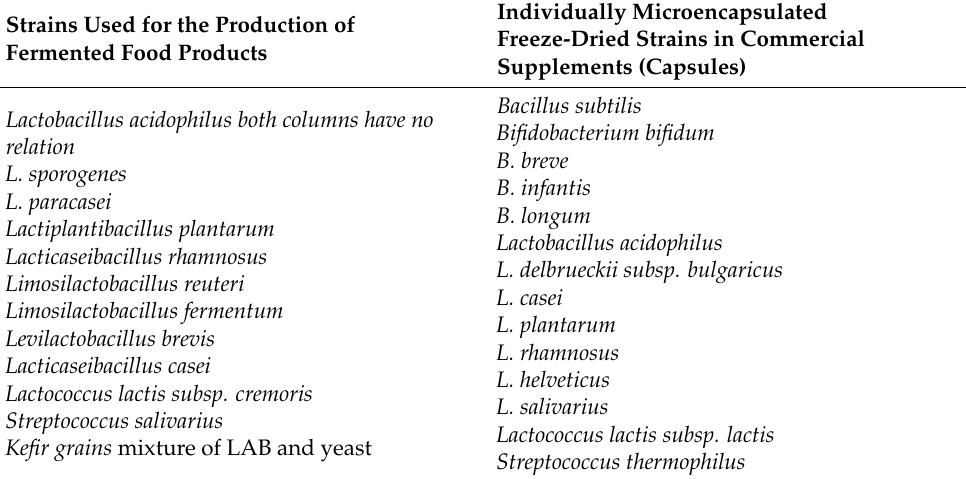
Table 2. Microorganisms used as probiotics in food fermentation and oral supplements [16–21]. Strains Used for the Production